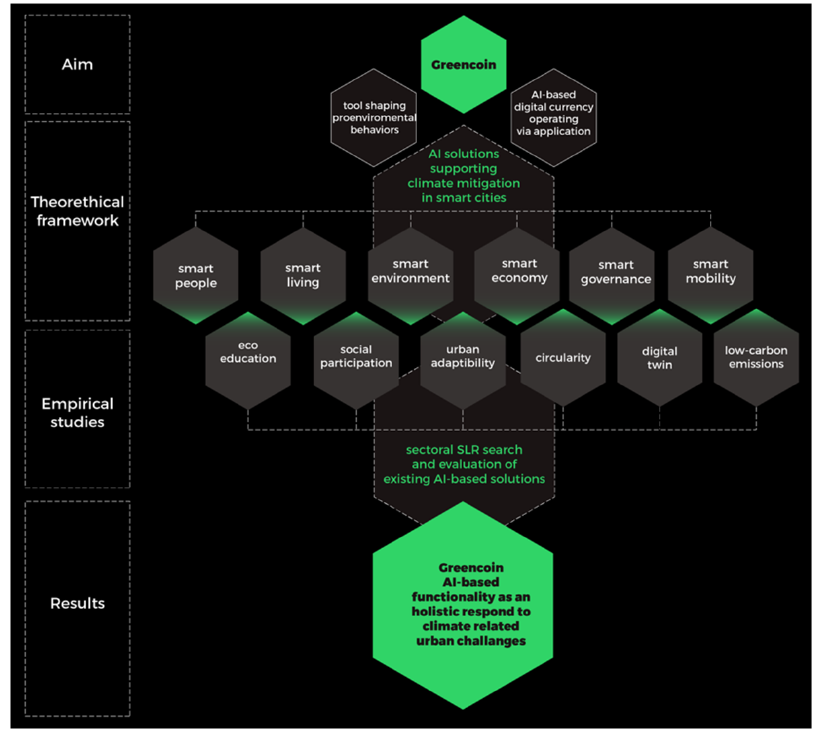
Figure 3. Research format. Authors’ own elaboration (based on methodological approach of Giffinger et al. [6]).